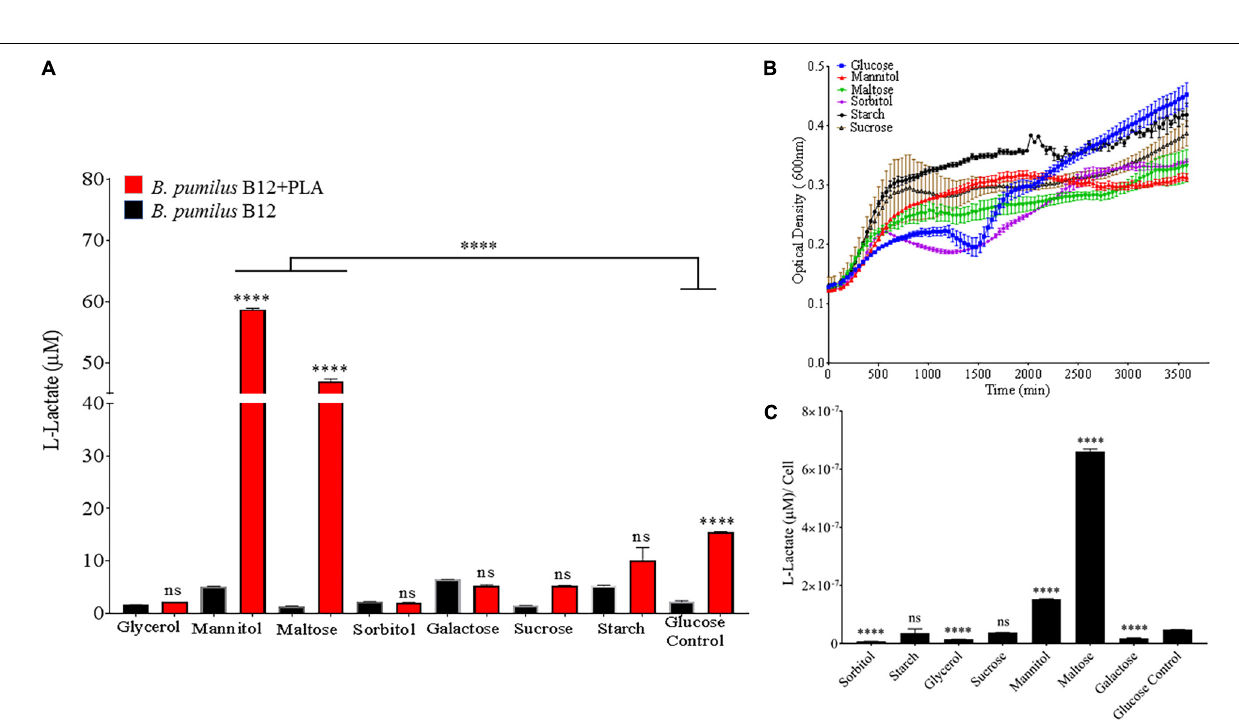
Frontiers in Microbiology |